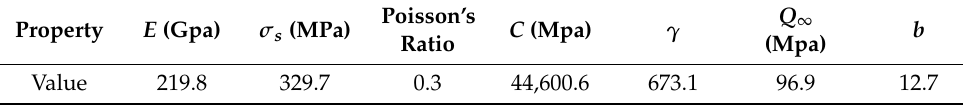
Table 1. Material properties employed in the finite element